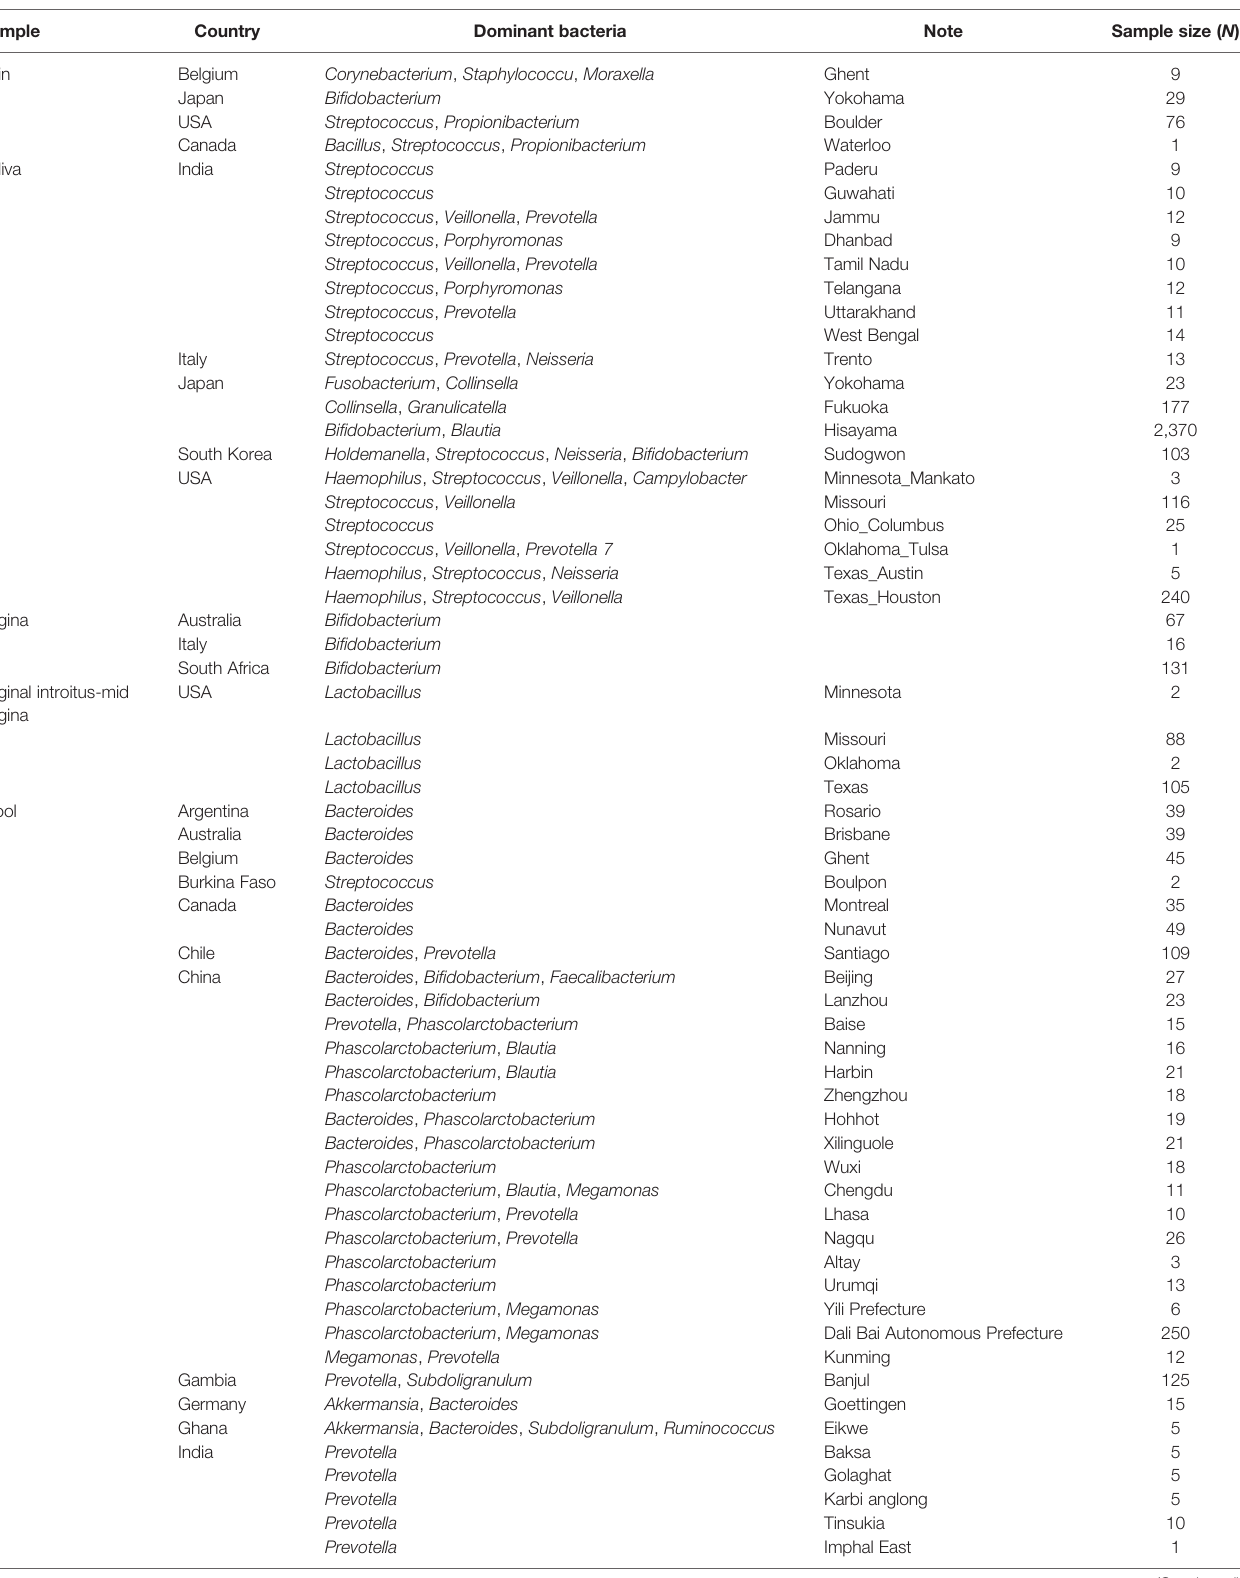
TABLE 1 | Distribution of dominant bacteria (over 10%) by countries offour body areas including skin, saliva, vagina, and stool from the Forensic Microbiome Database (FMD).